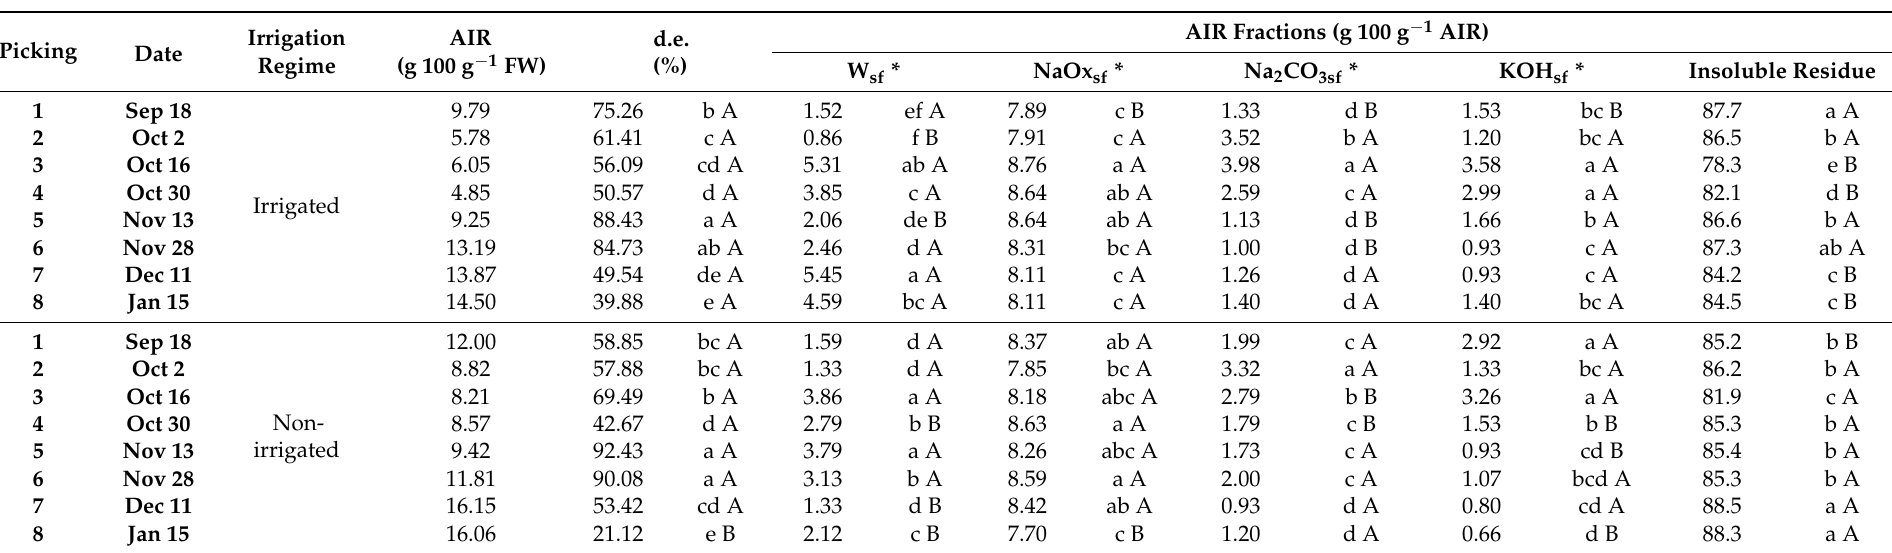
Table 2. Yield of alcohol-insoluble residue (AIR) and AIR fractions recovered during fruit ripening of irrigated and non-irrigated ‘Arbequina’